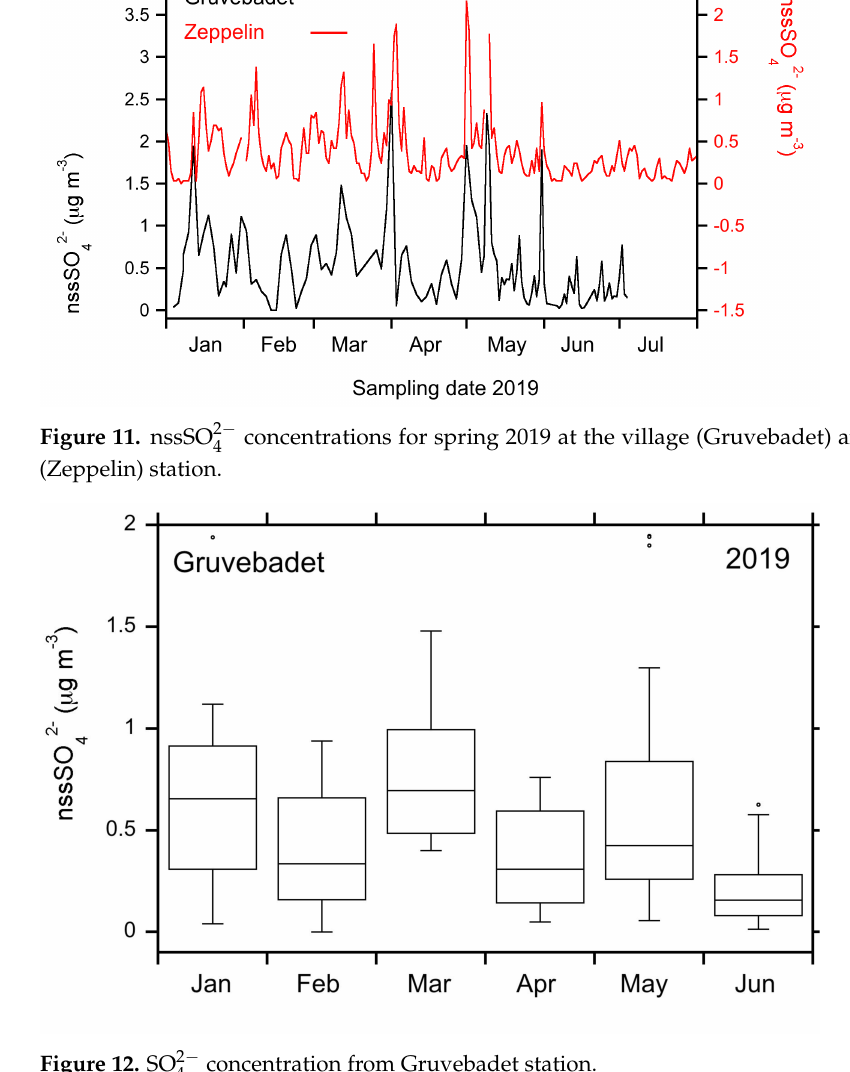
Figure 12. SO 2 − concentration from Gruvebadet 4